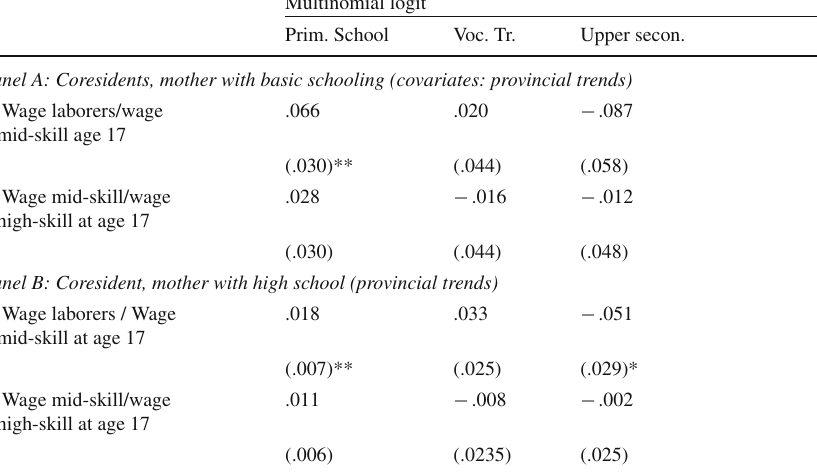
Table 8 Schooling attainment at age 25 and return to skill at age 17—males, by parental background. Source : own computations using the Spanish Employment Survey (EPA, 2001–2009) merged with wages in the Registry of collective agreements (1993–2001) Multinomial logit Prim. School Voc. Tr. Upper